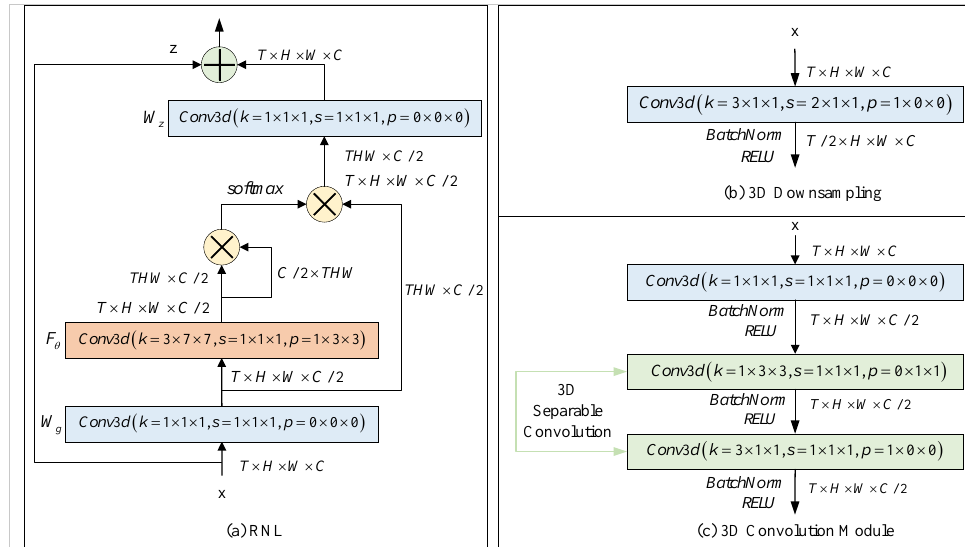
Figure 4. Overview of RNL, 3D downsampling, and 3D convolution module,